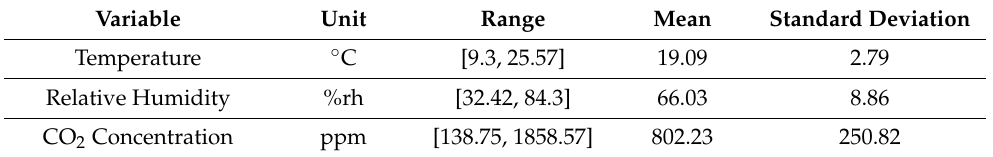
Table 1. Statistical information of the rabbit house environment variables. Variable